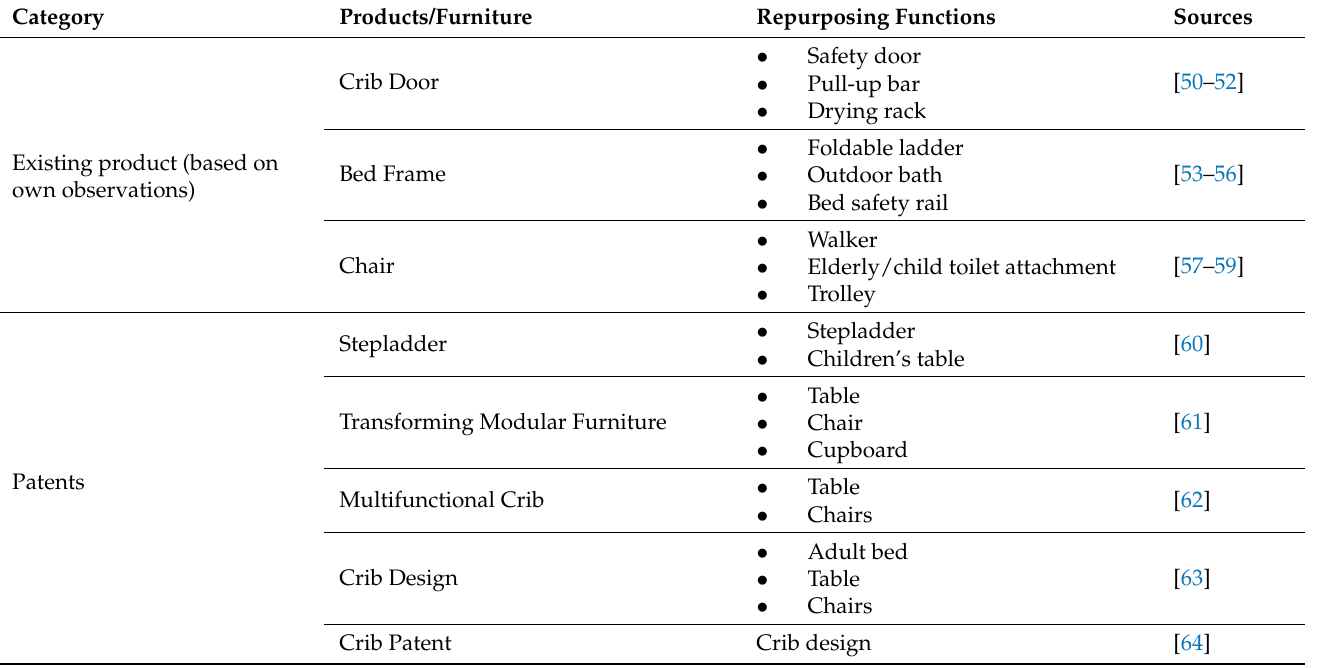
Table 3. Repurposable functions of products and